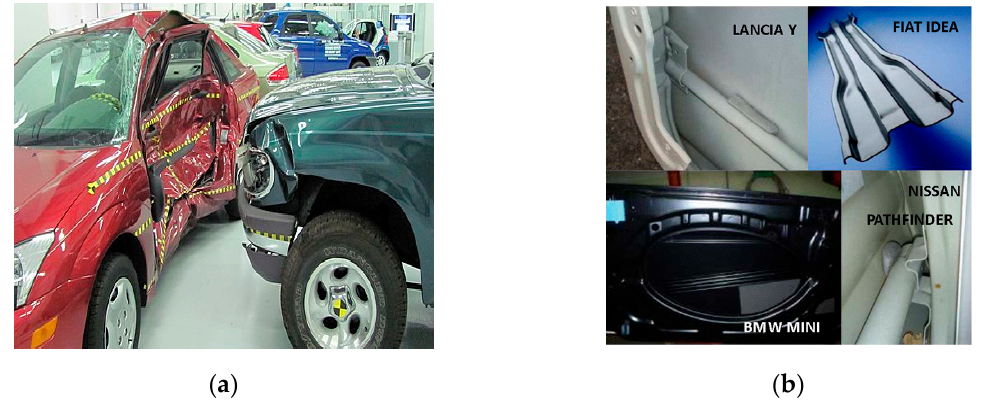
Figure 1. ( a ) Example of side impact between vehicles (source of image: Brady Holt, CC BY 3.0, via Wikimedia Commons). ( b ) Example of door intrusion beams/side impact beams (source of image: Strano. m, CC BY 3.0, via Wikimedia Commons).